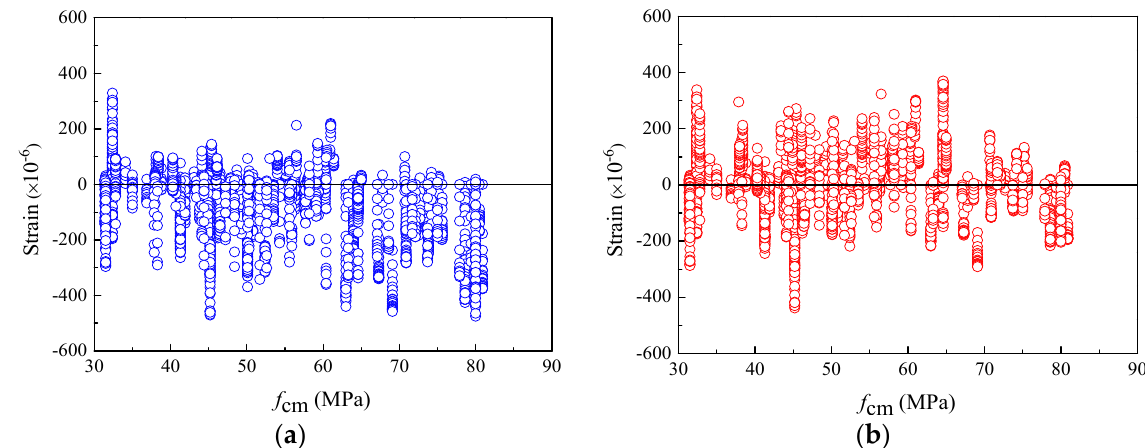
Figure 2. The residuals of shrinkage strain for CEB-FIP models versus f cm . ( a ) Residuals for CEB-FIP 1990 model ( b ) Residuals for CEB-FIP 2010 model.